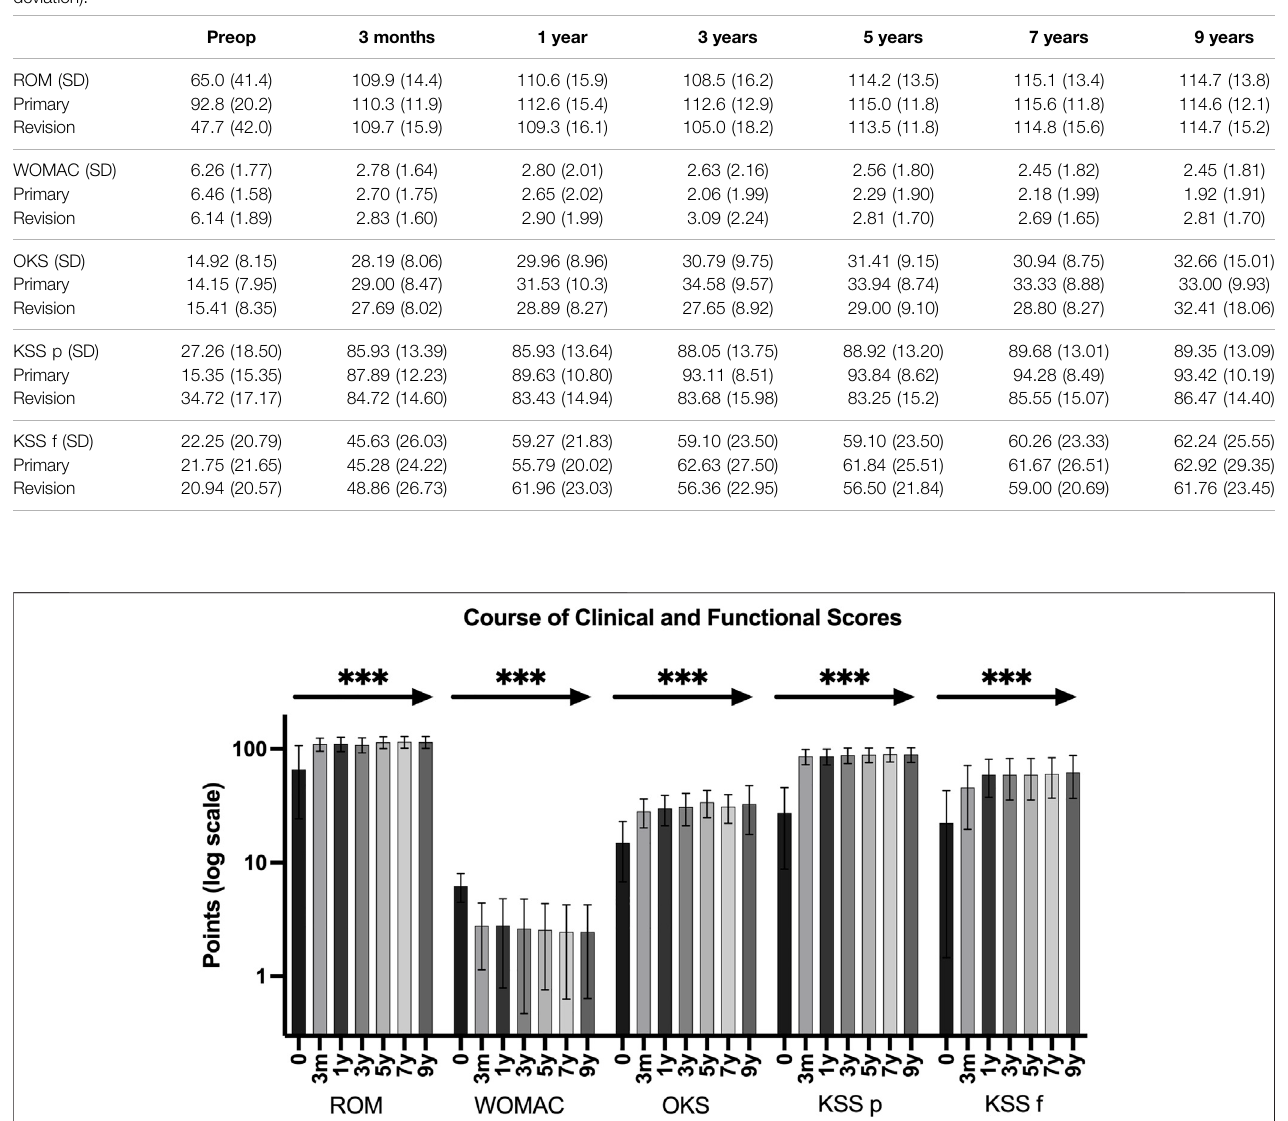
signi fi cance. Statistical analyses were performed using R v4.1.0 (R Software), SPSS v26 (IBM Corporation) and GraphPad Prism 9 (Graphpad Software).